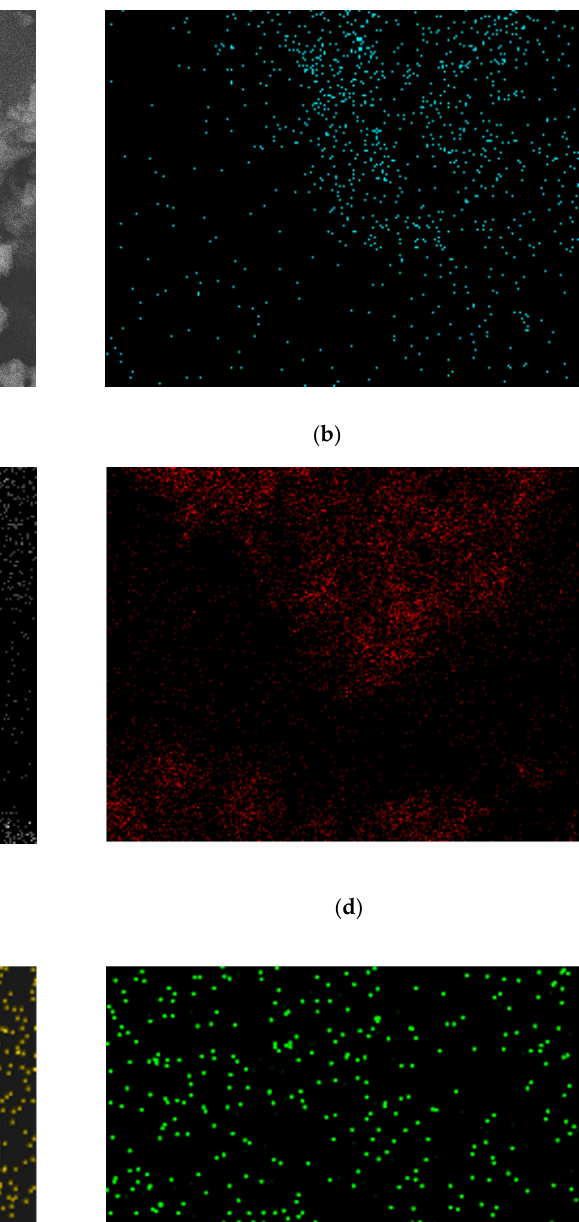
Figure 6. XRD of various BaAlO x powders prepared at different ratios of Ba and Al contacts.